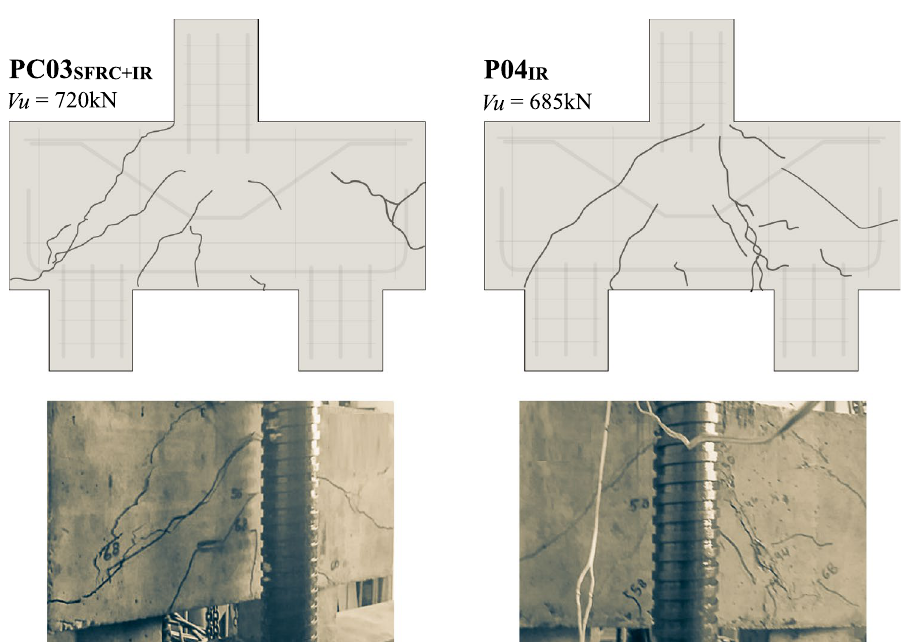
Figure 14. Final aspect of the pile caps after their failures with inclined shear